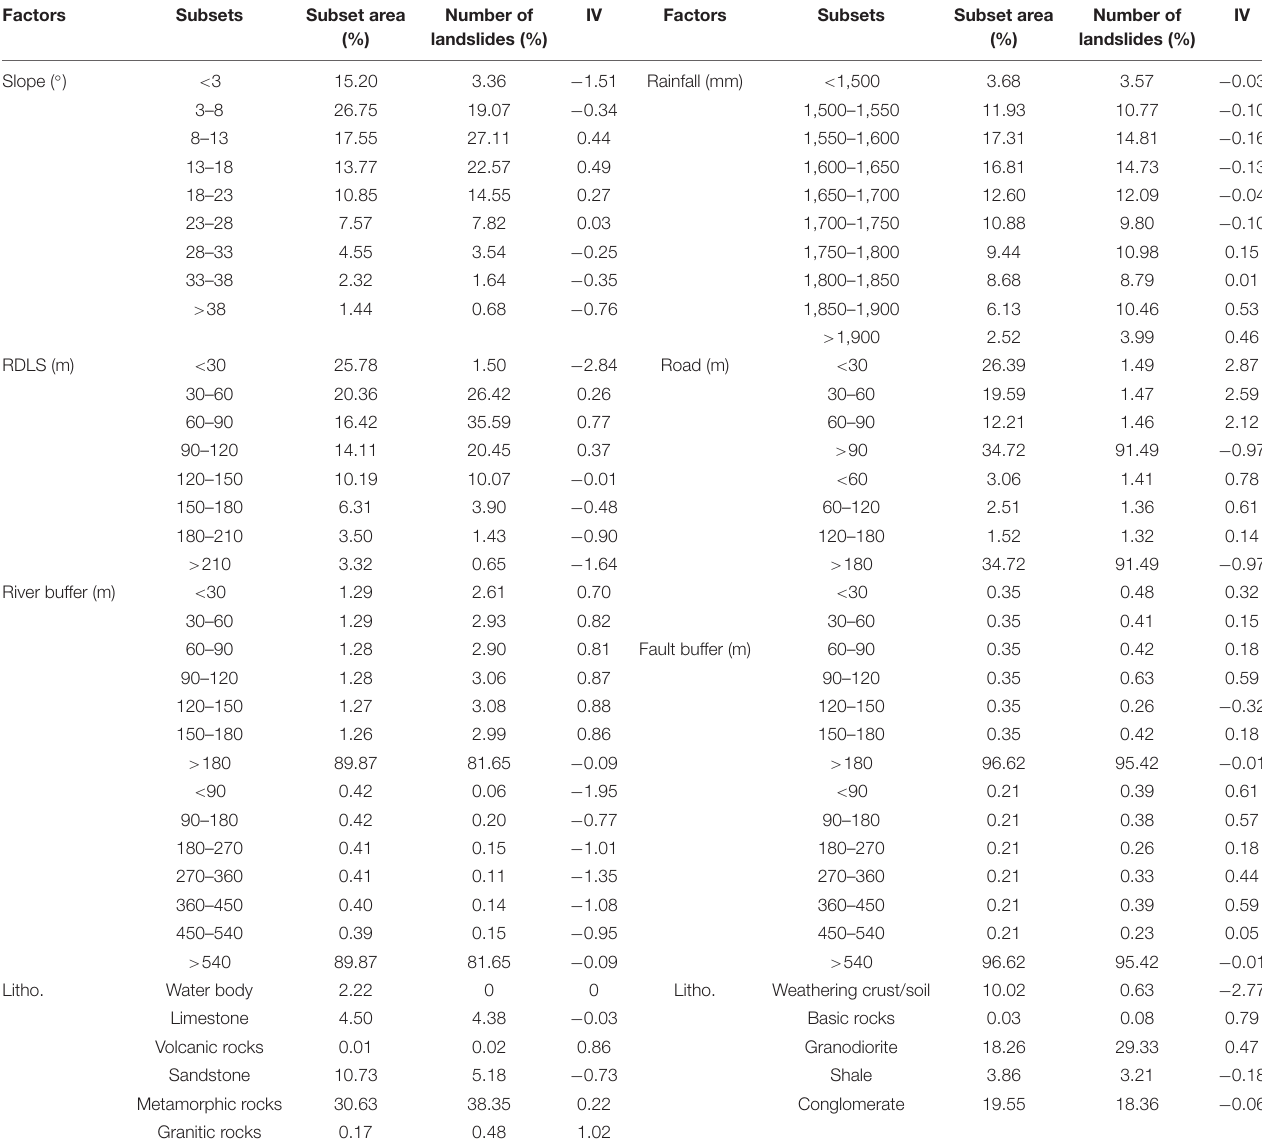
TABLE 2 | Information values (IVs) of different subsets of the geo-environmental factors contributing to landslides. Factors Subsets Subset area